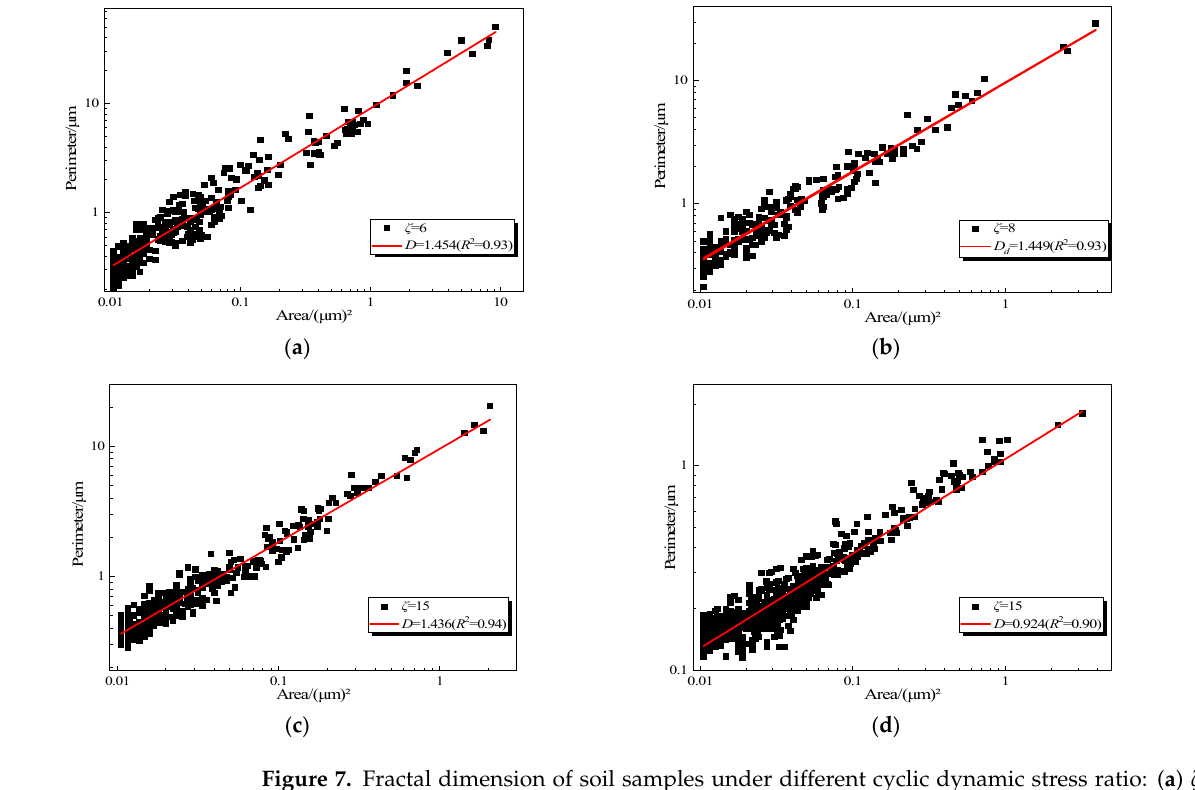
Figure 7. Fractal dimension of soil samples under different cyclic dynamic stress ratio: ( a ) ζ = 6; ( b ) ζ = 8; ( c ) ζ = 10; ( d ) ζ = 15.